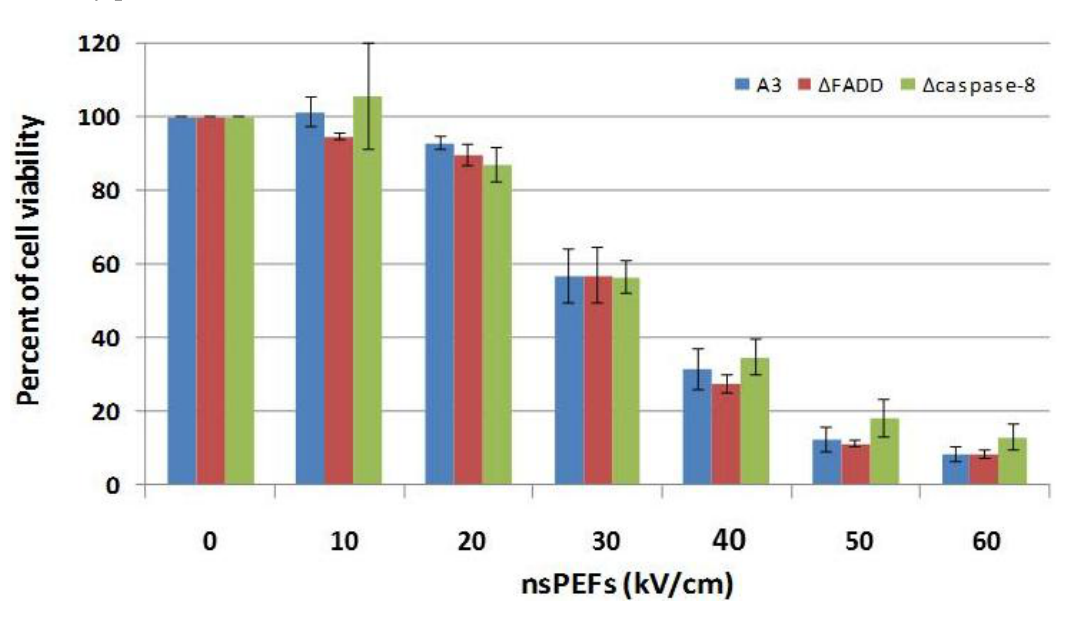
Figure 6. NsPEF-induced cell death in Jurkat clones does not require the DISC. Jurkat (cid:70)(cid:79)(cid:82)(cid:81)(cid:72)(cid:86)(cid:3)(cid:87)(cid:75)(cid:68)(cid:87)(cid:3)(cid:68)(cid:85)(cid:72)(cid:3)(cid:71)(cid:72)(cid:73)(cid:76)(cid:70)(cid:76)(cid:72)(cid:81)(cid:87)(cid:3)(cid:76)(cid:81)(cid:3)(cid:41)(cid:36)(cid:39)(cid:39)(cid:3)(cid:11)(cid:507)(cid:41)(cid:36)(cid:39)(cid:39)(cid:12)(cid:3)(cid:82)(cid:85)(cid:3)(cid:71)(cid:72)(cid:73)(cid:76)(cid:70)(cid:76)(cid:72)(cid:81)(cid:87)(cid:3)(cid:76)(cid:81)(cid:3)(cid:70)(cid:68)(cid:86)(cid:83)(cid:68)(cid:86)(cid:72) - (cid:27)(cid:3)(cid:11)(cid:507)(cid:70)(cid:68)(cid:86)(cid:83)(cid:68)(cid:86)(cid:72) -8) as